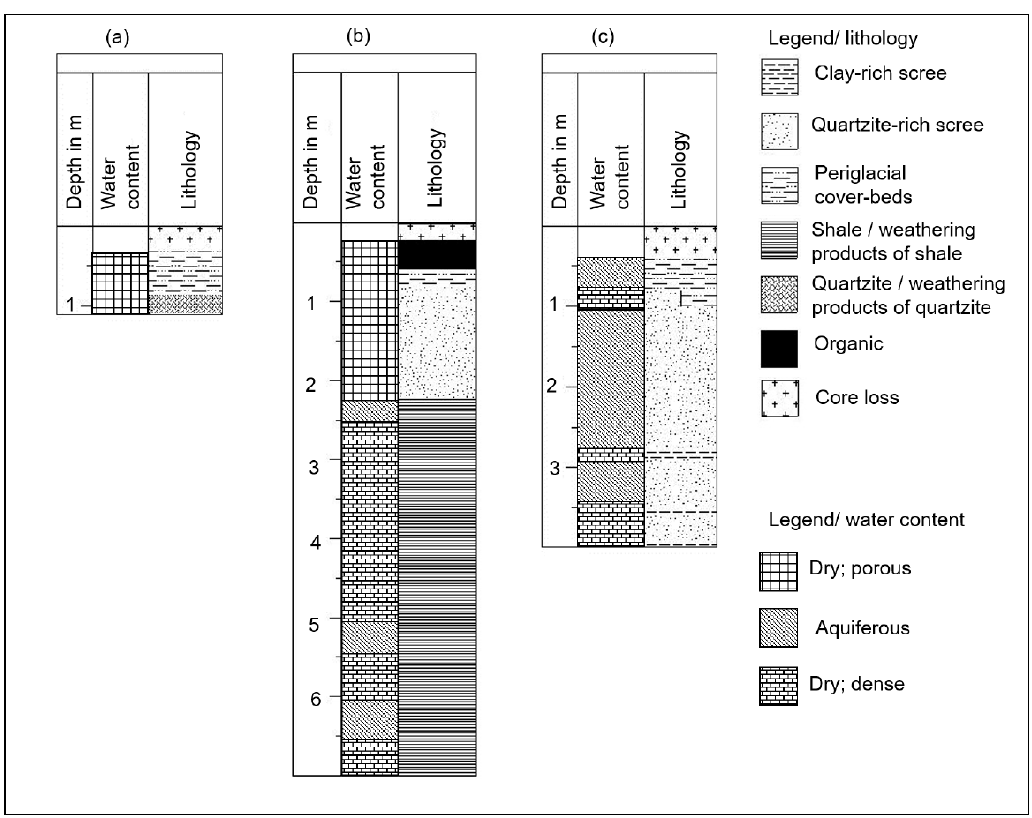
Figure 11. Boreholes: "Gebranntes Bruch": (a) B5, (b) B6, (c) B7.